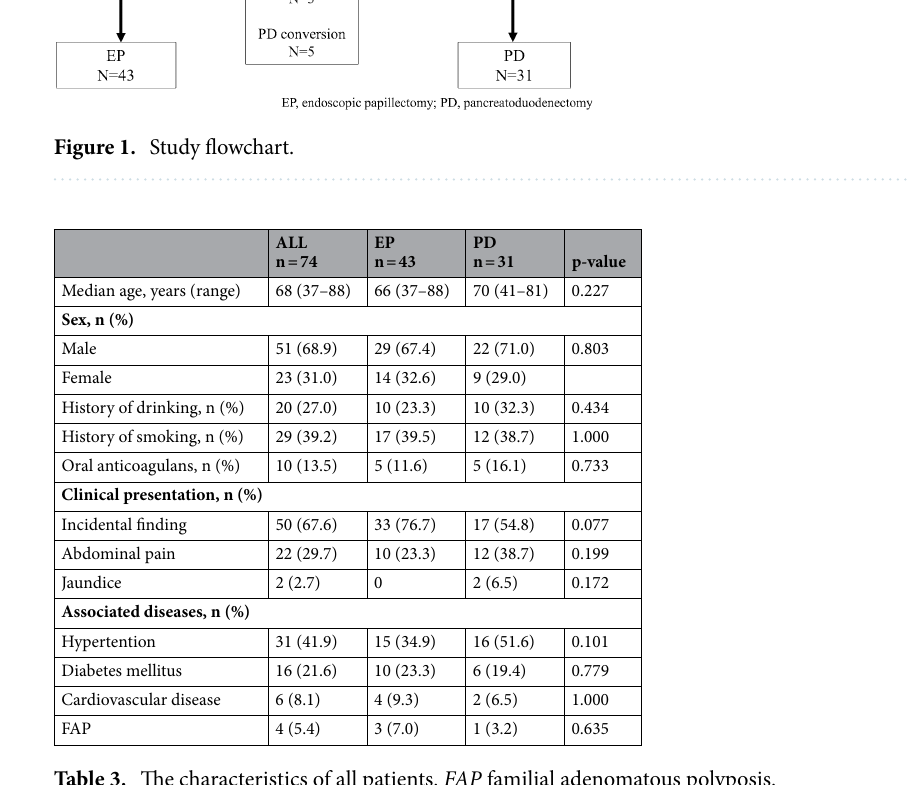
Table 3. The characteristics of all patients. FAP familial adenomatous